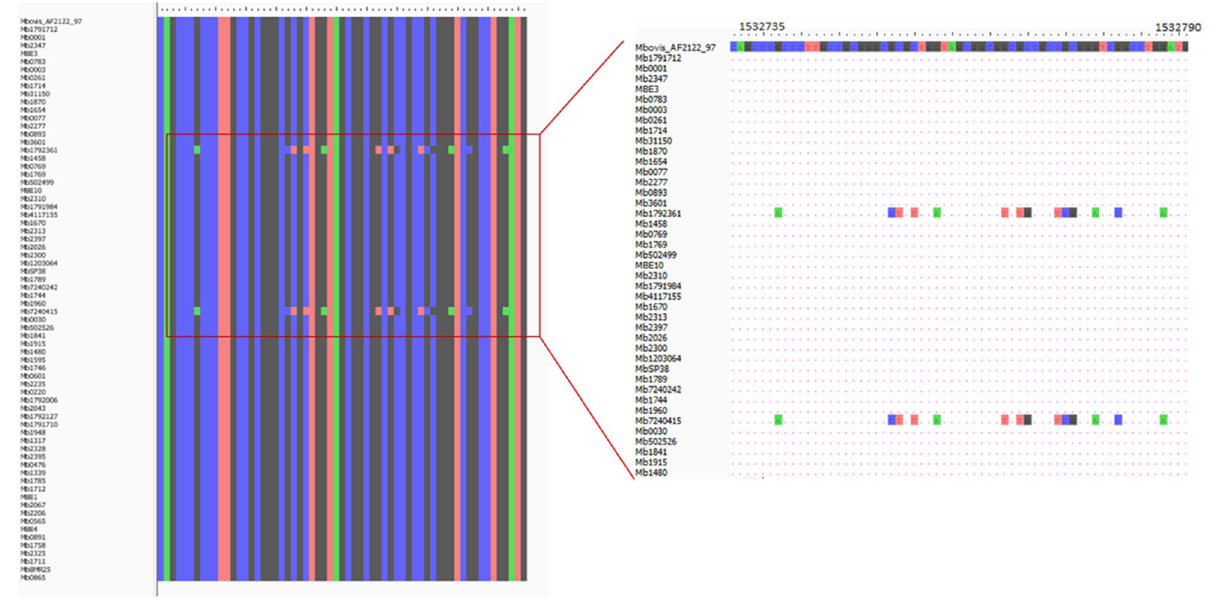
Figure 4. Detailed visualization of alignment in the recombination region of M. bovis dataset affecting the narX gene encoding a probable nitrate reductase. No gaps or undefined nucleotides were identified in the recombination region of internal nodes. This specific event was registered across Eu1 genomes. The quality of sequencing of narX gene was evaluated by read mapping against M. bovis AF2122/97. The SNP positions suggested in the recombination region were confirmed by applying the criteria referred to in the methods section (at least 20 reads and 0.9 frequency of alteration). The polymorphisms at narX gene were fully confirmed in genomes Mb1792361 and Mb7240415 (2.3%).